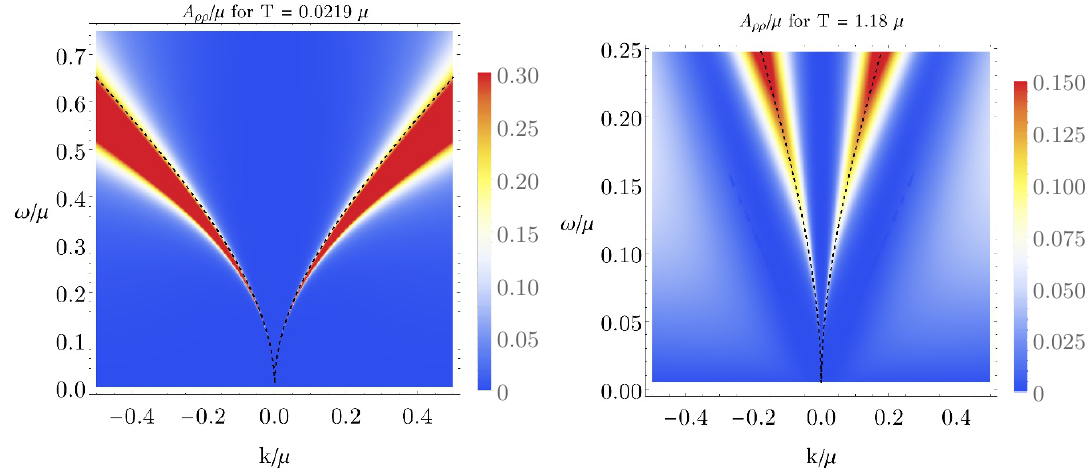
Figure 6. The density spectral function for T ’ 0 : 02 (cid:22) (left) and T ’ 1 : 2 (cid:22) (right). We have taken (cid:11) 2 = 2 = 1. Here we see that the sound modes from the Reissner-Nordstr(cid:127)om solution turn into p ! / j k j modes at low energies. The dashed black line represent the hydrodynamic solution for the dispersion relation ! 2 = 2 h (cid:26) i 2 j k j = 3 h (cid:15)